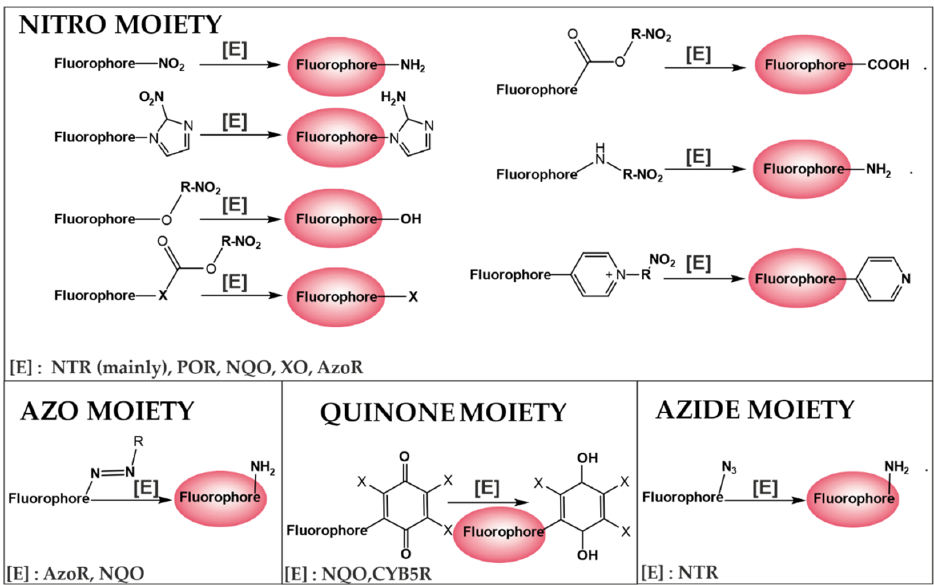
Figure 4. Overview of design strategies for fluorescent turn off–on probes for hypoxia imaging (based on ref [21]). [E]—oxidoreductase, NTR- Nitroreductase, POR—Cytochrome P450 reductase, NQO—Quinone oxidoreductase, XO—Xanthine oxidase, AzoR,—Azoreductase, CYB5R—Cytochrome b 5 reductase, R—benzyl, imidazole, thiophene, or pyrrole moiety. Apart from the nitroaromatic groups, azo derivatives can be another type of hypoxia- detecting moiety. Depending on the degree of hypoxia, the azo group can be reduced to